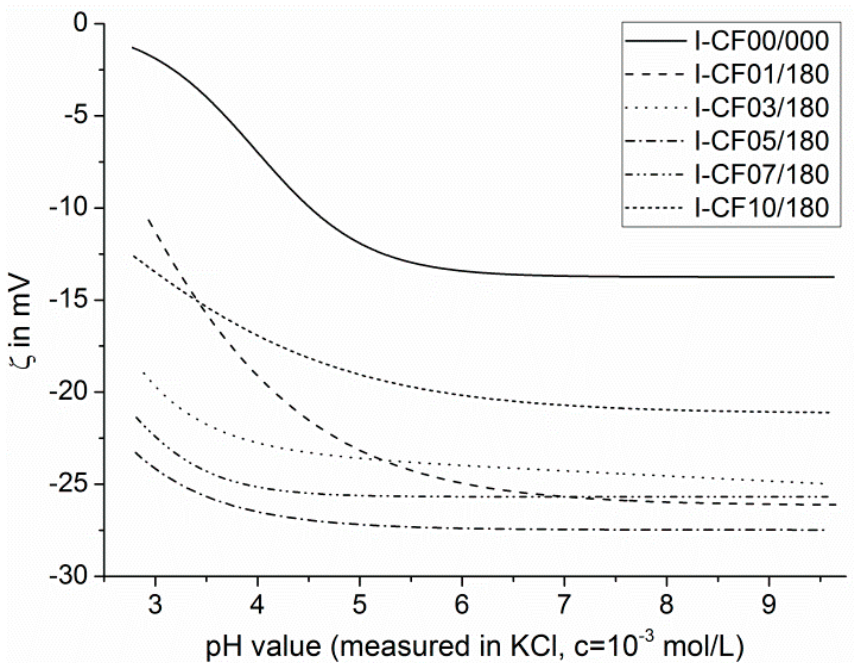
Figure 8. Dependence of the zeta potential ( ζ ) of differently treated carbon fiber samples on the pH values of a 1 × 10 − 3 mol · L − 1 aqueous KCl solution.